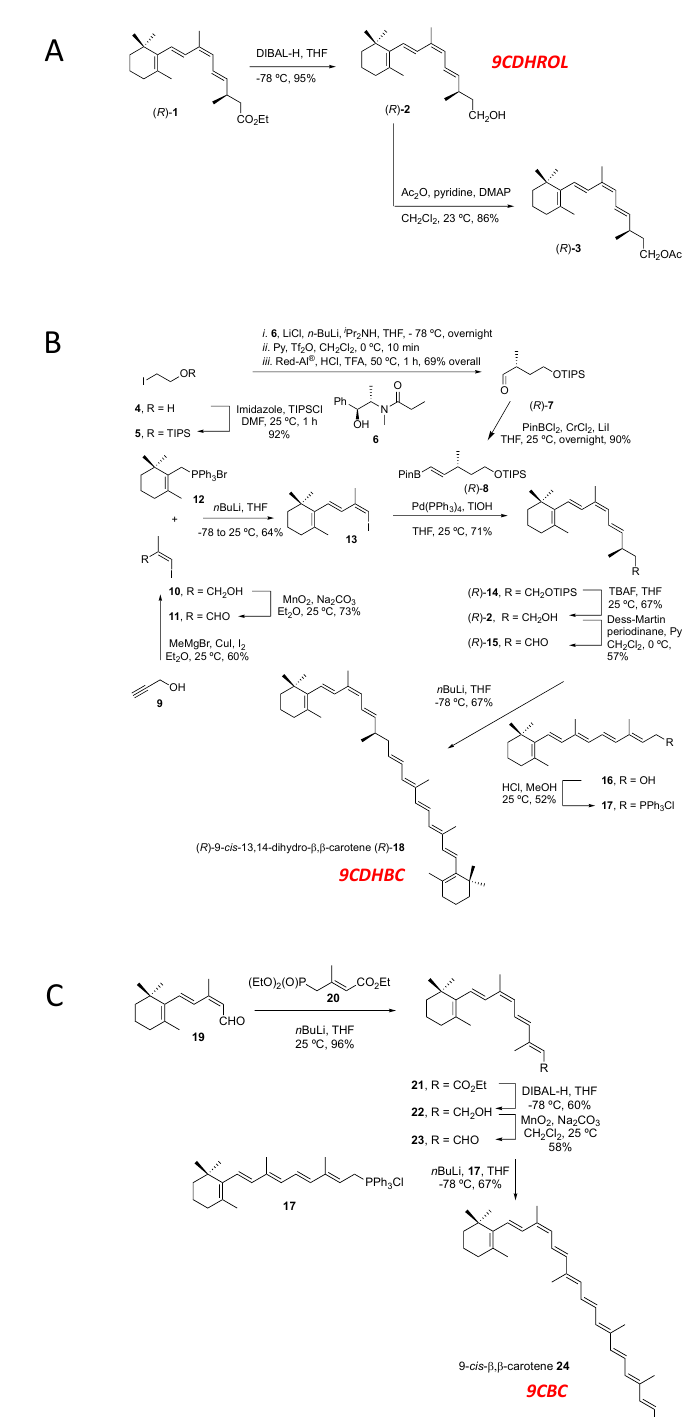
Figure 1. Synthesis of vitamin A5/X and provitamin A5/X. ( A ): Synthesis of ( R )-9- cis -13,14- dihydroretinol (9CDHROL), ( R )-(2) and its acetate ( R )-(3) ; ( B ). Synthesis of ( R )-9- cis -13,14-dihydro- β , β -carotene (9CDHBC), ( R )-(18) ; ( C ). Synthesis of 9- cis - β , β -carotene (9CBC) (24) . (3 R ,4 E ,6 Z ,8 E )-3,7-Dimethyl-9-(2,6,6-trimethylcyclohex-1-en-1-yl)nona-4,6,8-trien-1-ol ( R )- (2) : To a cooled ( − 78 ◦ C) solution of ethyl (3 R ,4 E ,6 Z ,8 E )-3,7-dimethyl-9-(2,6,6-trimethylcyclohex- 1-en-1-yl)nona-4,6,8-trienoate ( R )-(1) (ethyl ( R )-9- cis -13,14-dihydroretinoate) (32.0